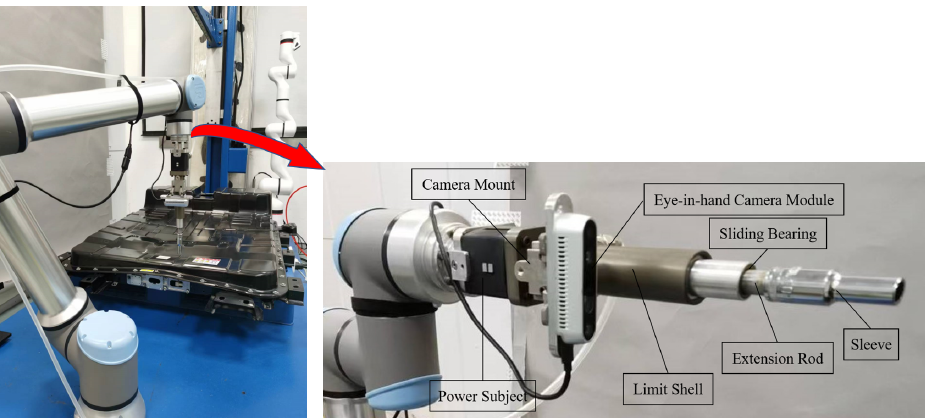
Figure 1. A passive and compliant pneumatic torque actuator with vision sensing.